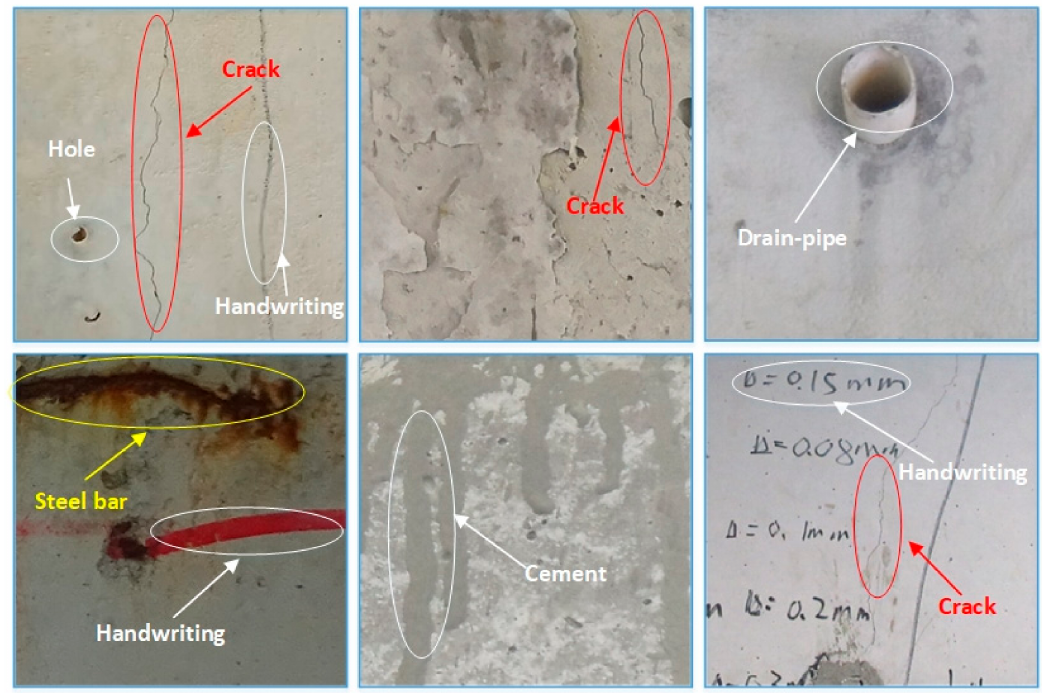
Figure 1. Some images taken under a bridge (including cracks, exposed steel bars and other